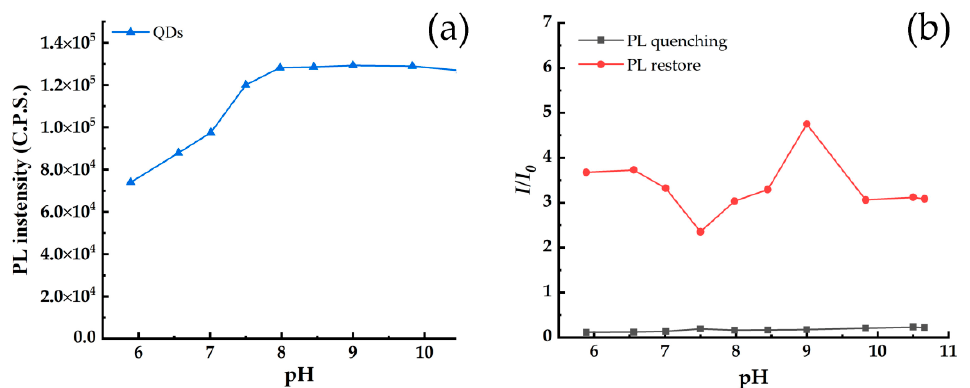
Figure 7. ( a ) The relationship between PL intensity of CdSe/CdS QDs and solution pH; ( b ) the effect of solution pH on the PL quenching and PL